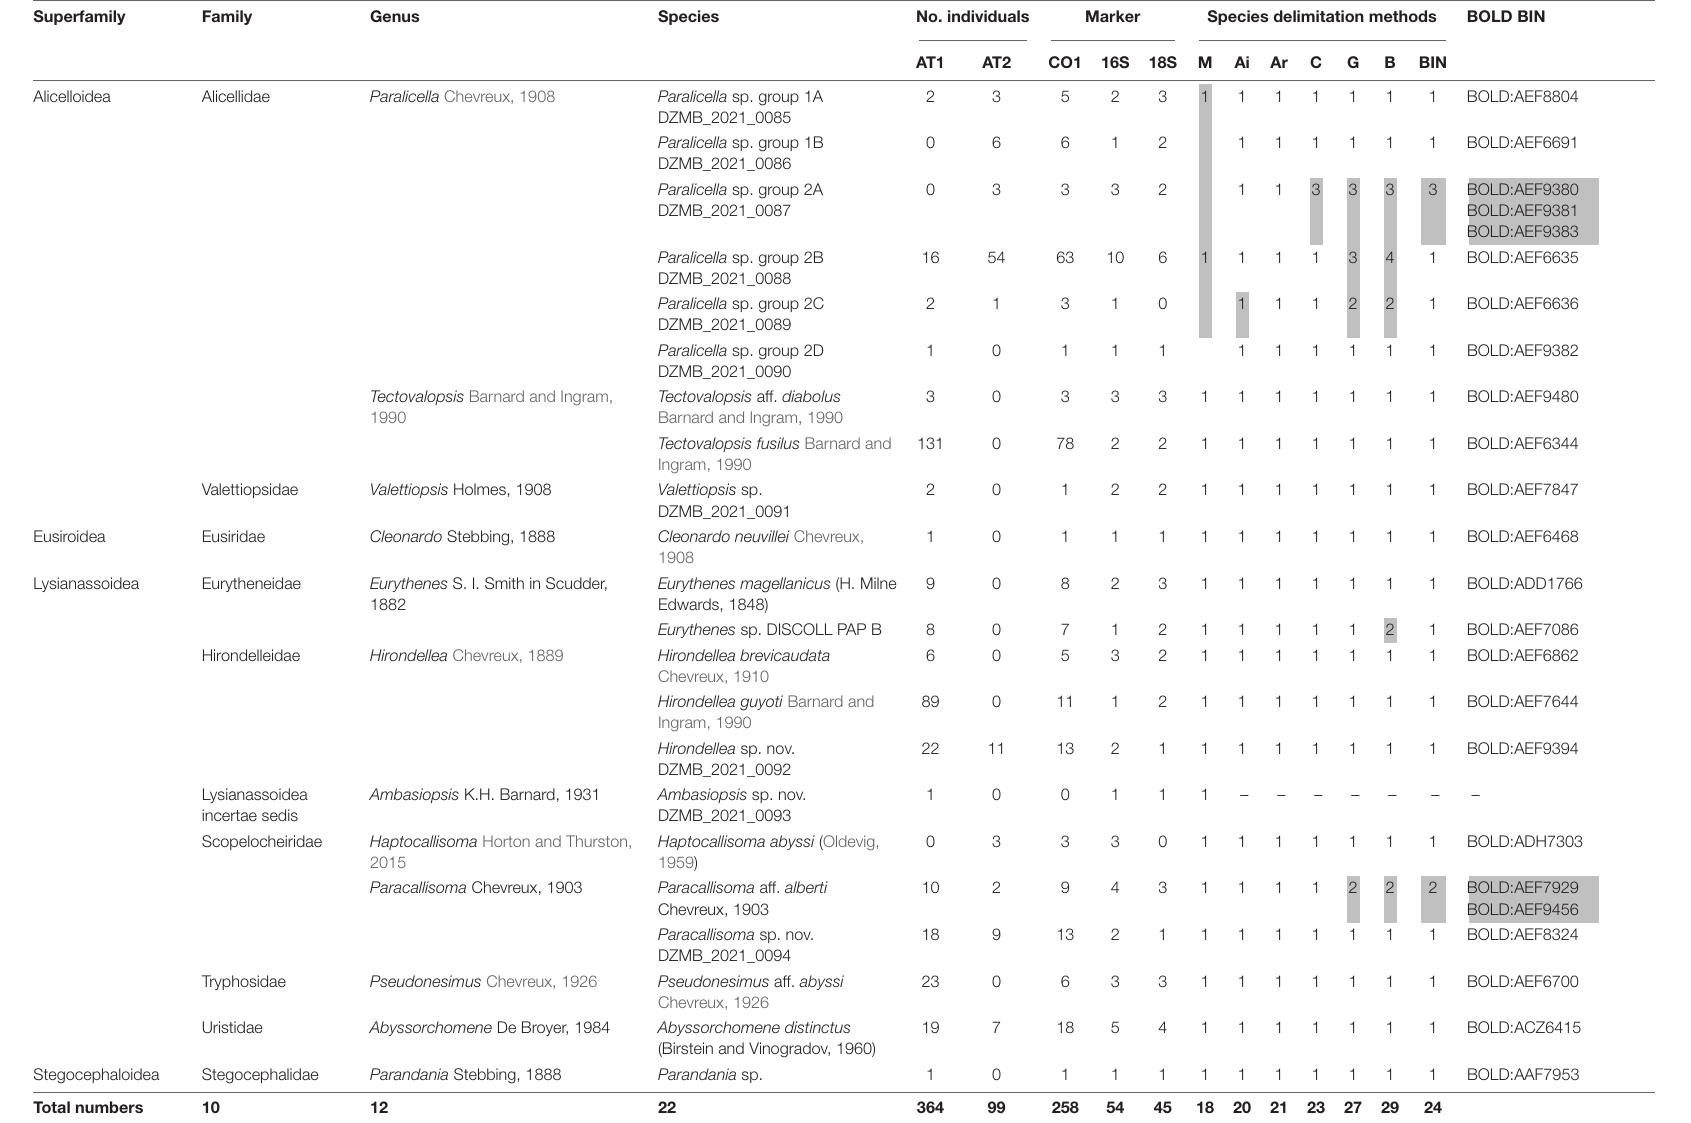
TABLE 3 | The list of taxa identified, with superfamily, family and genus information, number of sequences for COI, 16S, and 18S, morphological delimitation (M), number of MOTUs based on Automatic Barcode Gap Discovery (Ai, initial, and Ar, recursive, partition), CD-Hit (C), GMYC (G), bPTP (B), and BIN.